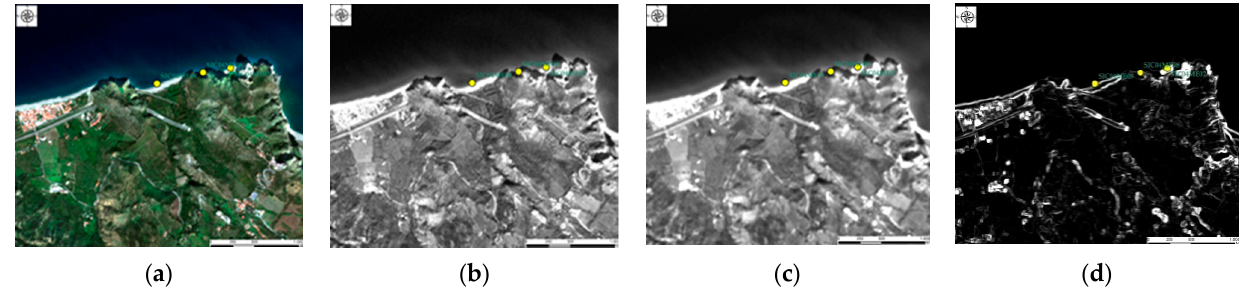
Figure 3. Sentinel-2 natural color composite image: ( a ) green band; ( b ) mean; ( c ) variance; ( d ) gray tone computed in the ENVI software with 3 ∗ 3 kernel.